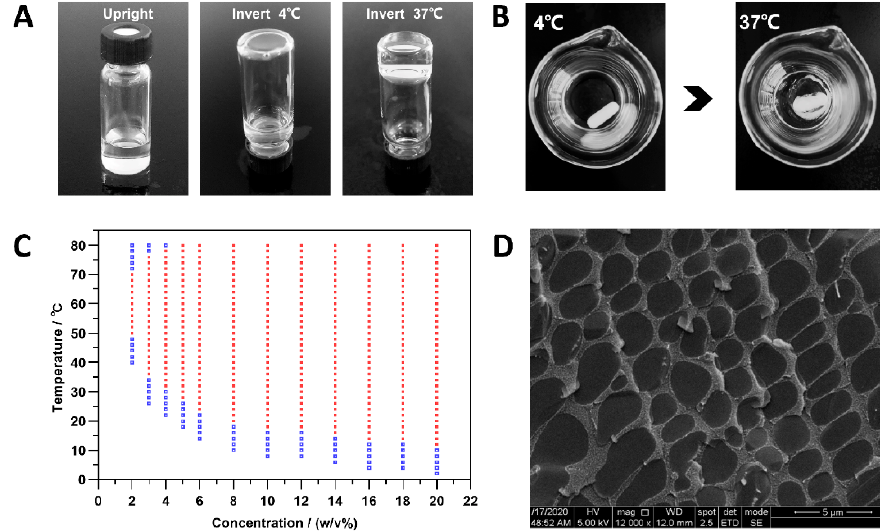
Figure 2. Sol–gel transition was tested by an inverting vial method ( A ) and a stirrer method ( B ); ( C ) phase diagrams of 2–20 w / v % copolymer aqueous solution (“  ” gelation occurred, “  ” solution con- ( C ) phase diagrams of 2–20 w / v % copolymer aqueous solution (“ ■ ” gelation occurred, “ □ ” solution dition); ( D ) Cryo-SEM image of the copolymer. condition); ( D ) Cryo-SEM image of the